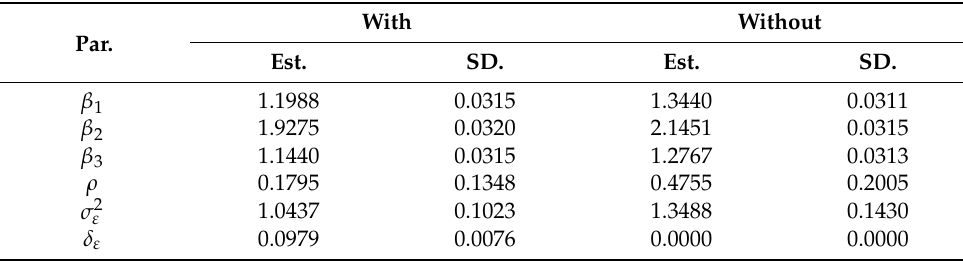
Table 1. Bayesian estimation with or without influence point 6 and 19 in the real example.